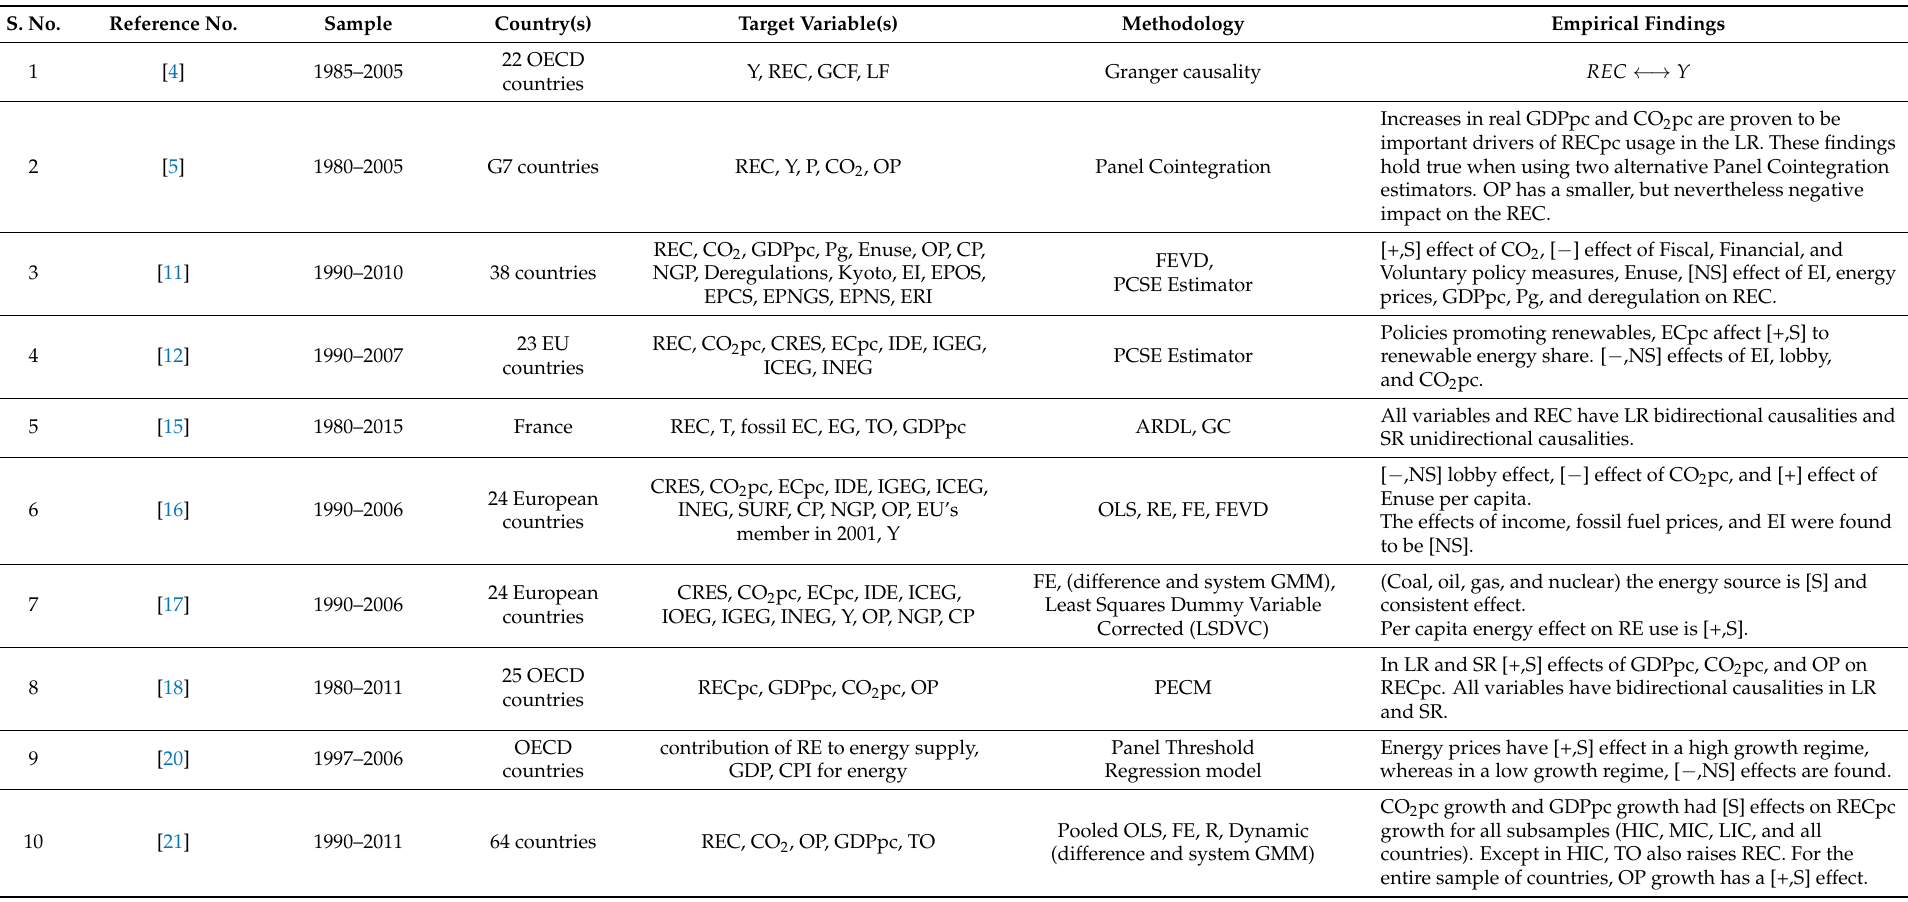
Table 1. Summary of previous studies on determinants of renewable energy